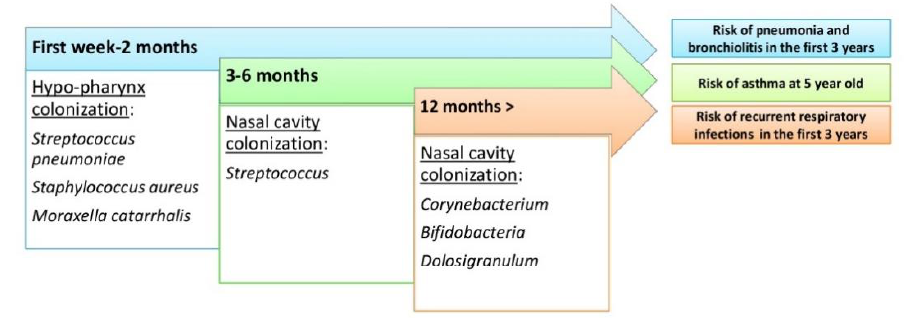
Figure 3. The evolution of the upper respiratory tract microbiome during human life and risk of respiratory tract diseases.